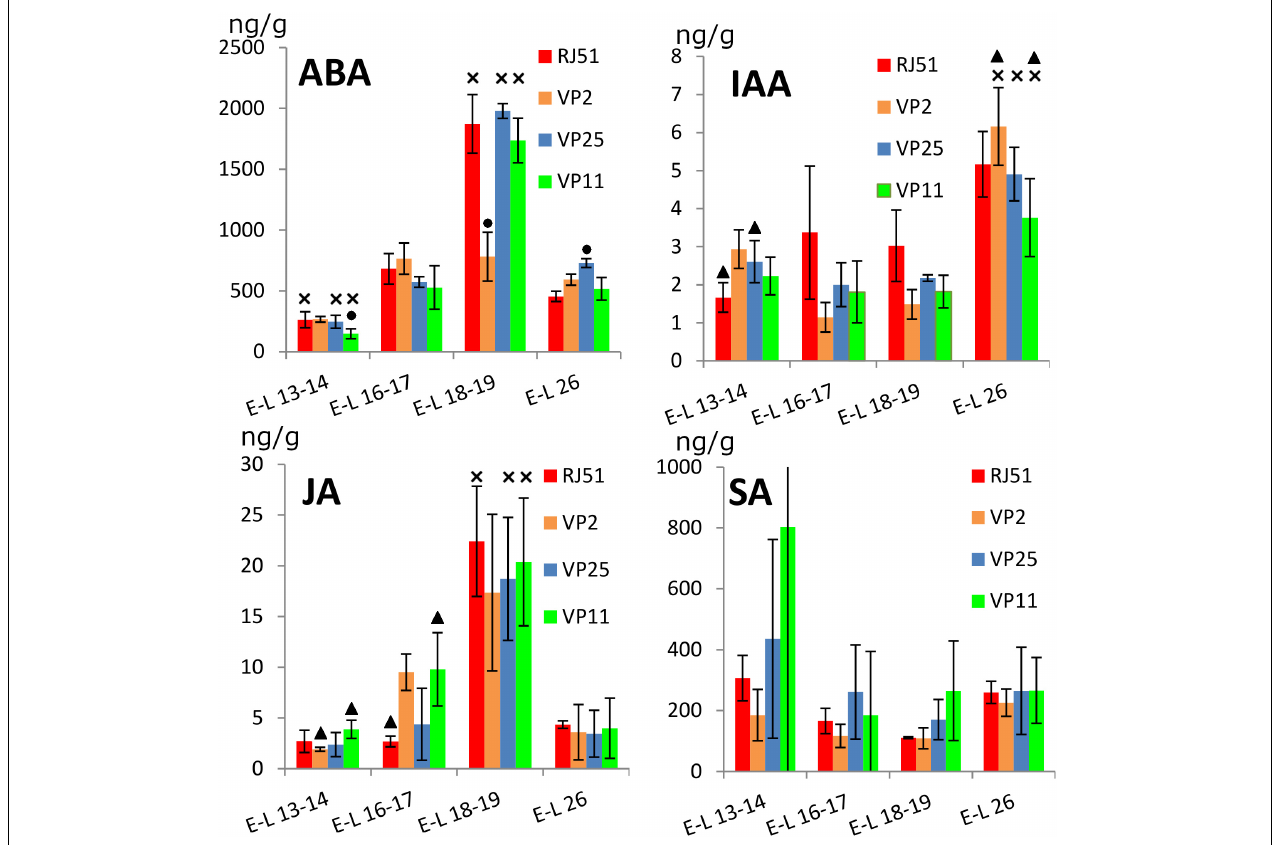
FIGURE 2 | Abundance (ng/g fresh weight) of plant hormones within the grapevine flower development. ABA, abscisic acid; SA, salicylic acid; IAA, indol-3-acetic acid; JA, jasmonic acid. Cross, significantly different against the other three stages; circle, significantly different against the other three clones; and triangle, significant differences between two clones with different